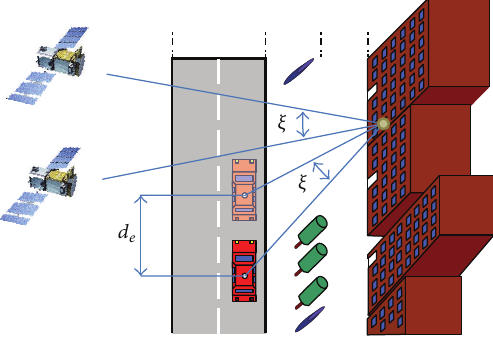
Figure 18: Relation between the correlation angle 𝜉 and the reflector position and echo life distance, respectively.